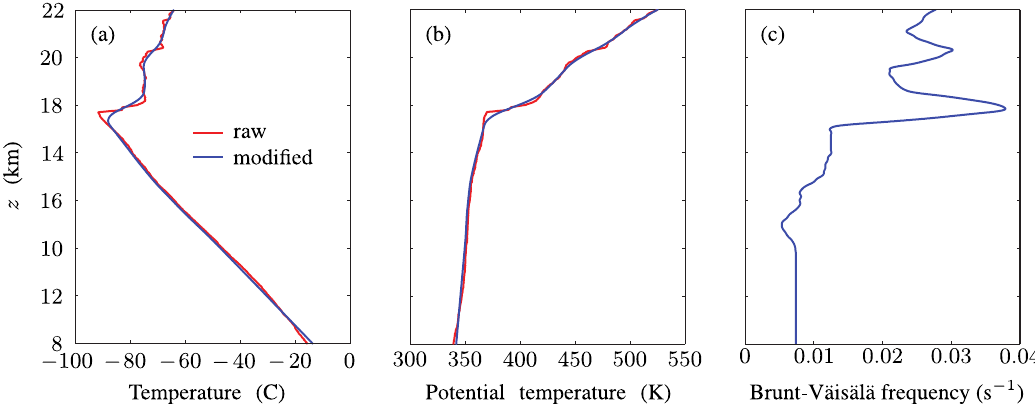
Fig. 1. Temperature (a) and potential temperature (b) of the raw and modified soundings, and the Brunt-V¨ais¨al¨a frequency (c) of the modified